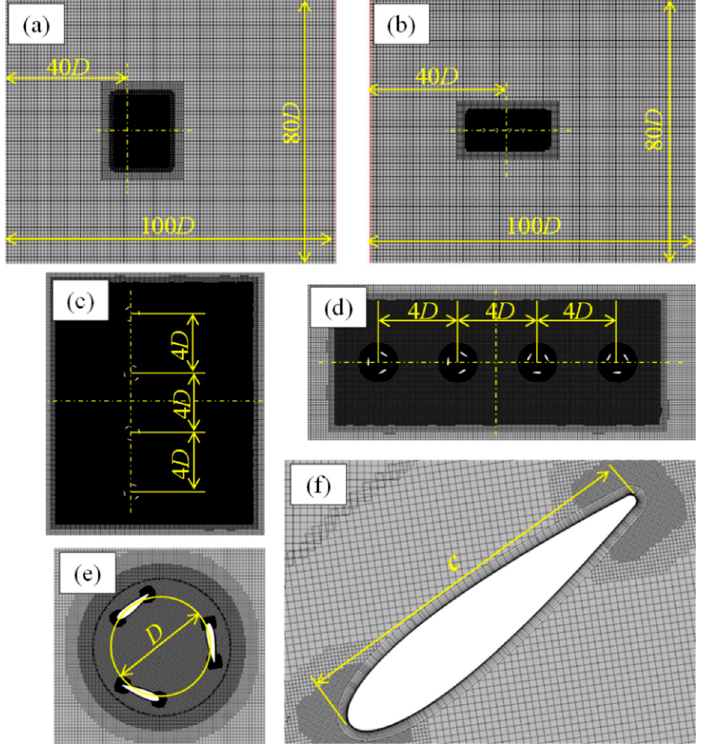
Figure A5. Computation meshes for the CFD analysis of four-rotor layouts: ( a ) whole domain of the parallel layout; ( b ) whole domain of the tandem layout; ( c ) the mesh around the 4 rotors in the parallel array; ( d ) the mesh around the 4 rotors in the tandem array; ( e ) the mesh around a rotor; ( f ) the mesh around a